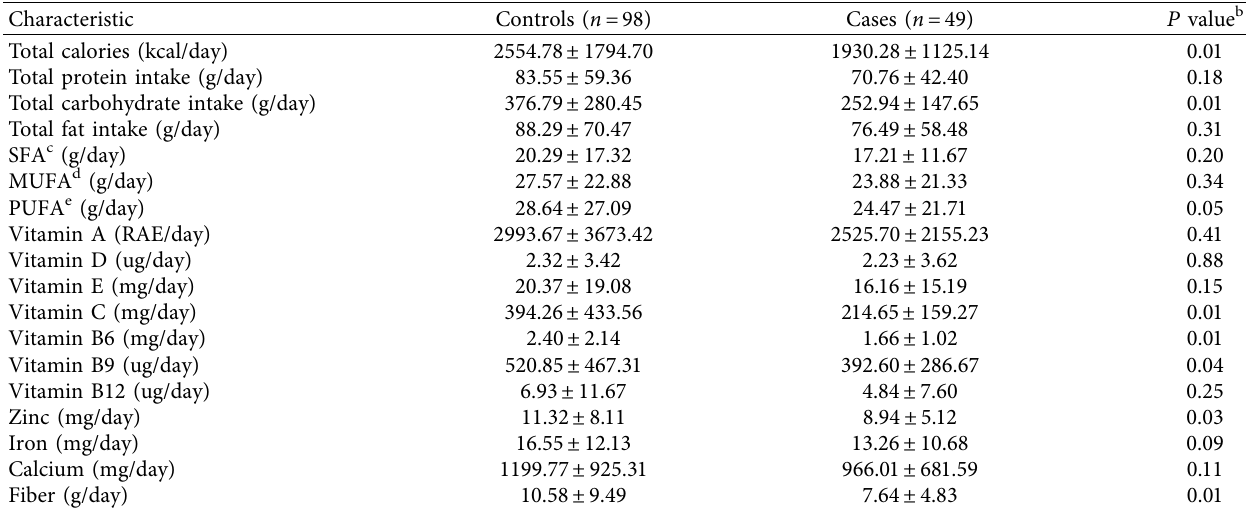
Table 2: Distribution of macro- and micronutrient intakes across case and control participants a